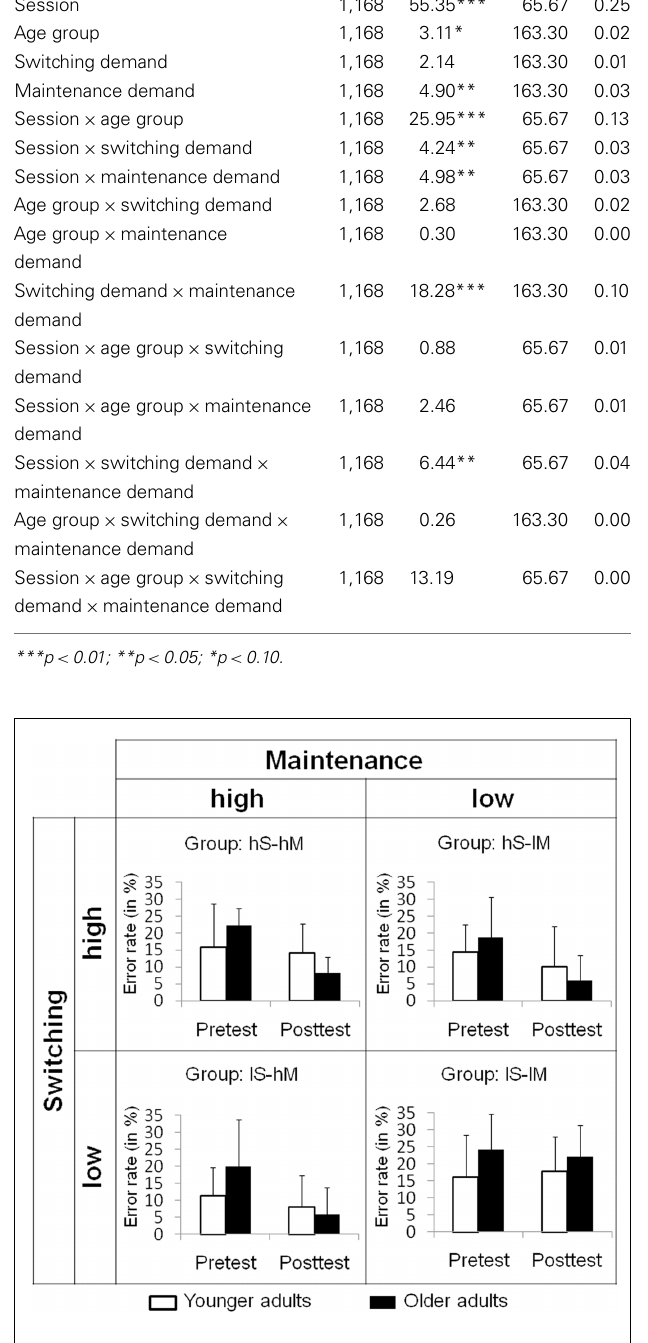
FIGURE 2 | Error rates (%) as a function of session, age group, and training